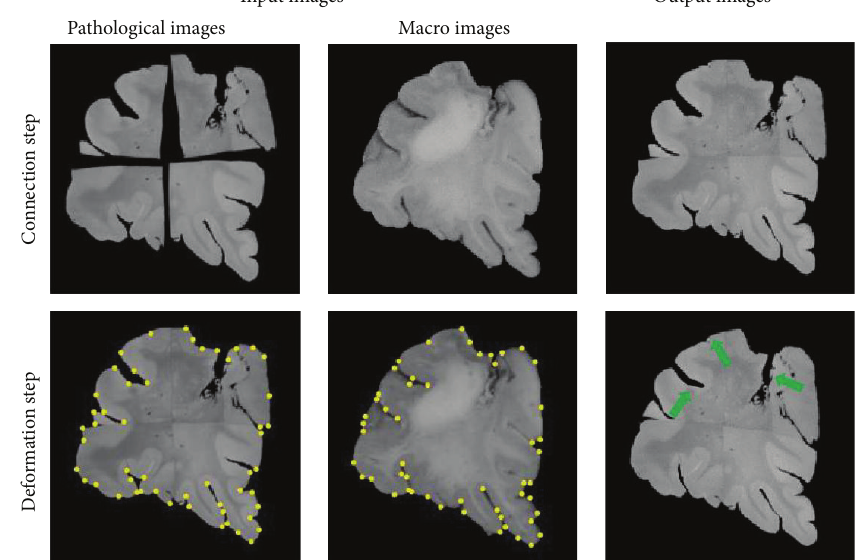
Figure 2: Result of each